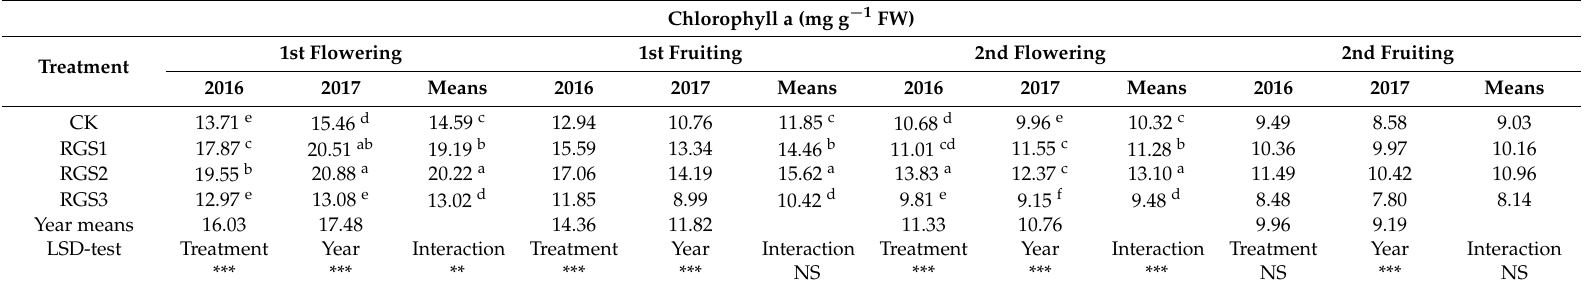
Table 1. Effect of amendment with raw garlic stalk on Chlorophyll a content in eggplant leaves.